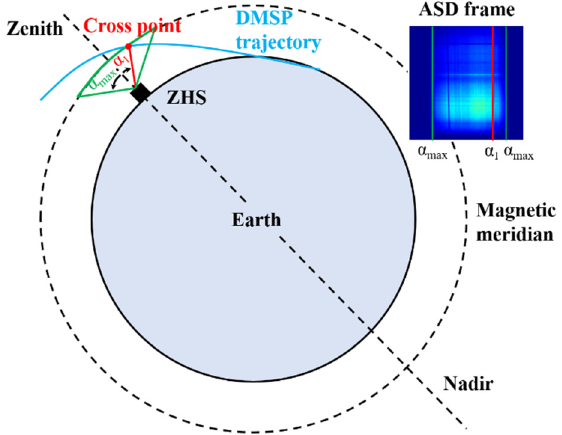
Figure 6. Illustration of the Defense Meteorological Satellite Program (DMSP) satellite’s passing through the magnetic meridian above ZHS.